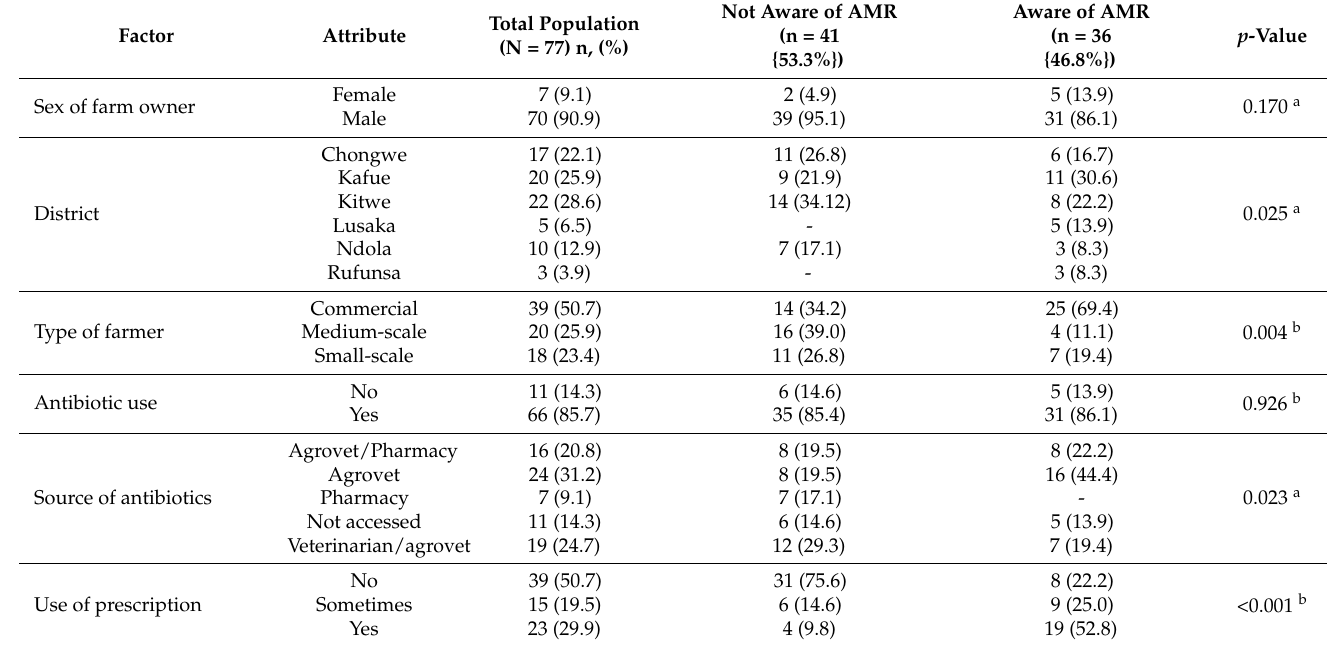
Table 1. Study characteristics of participants by awareness of AMR in Lusaka and Copperbelt provinces of